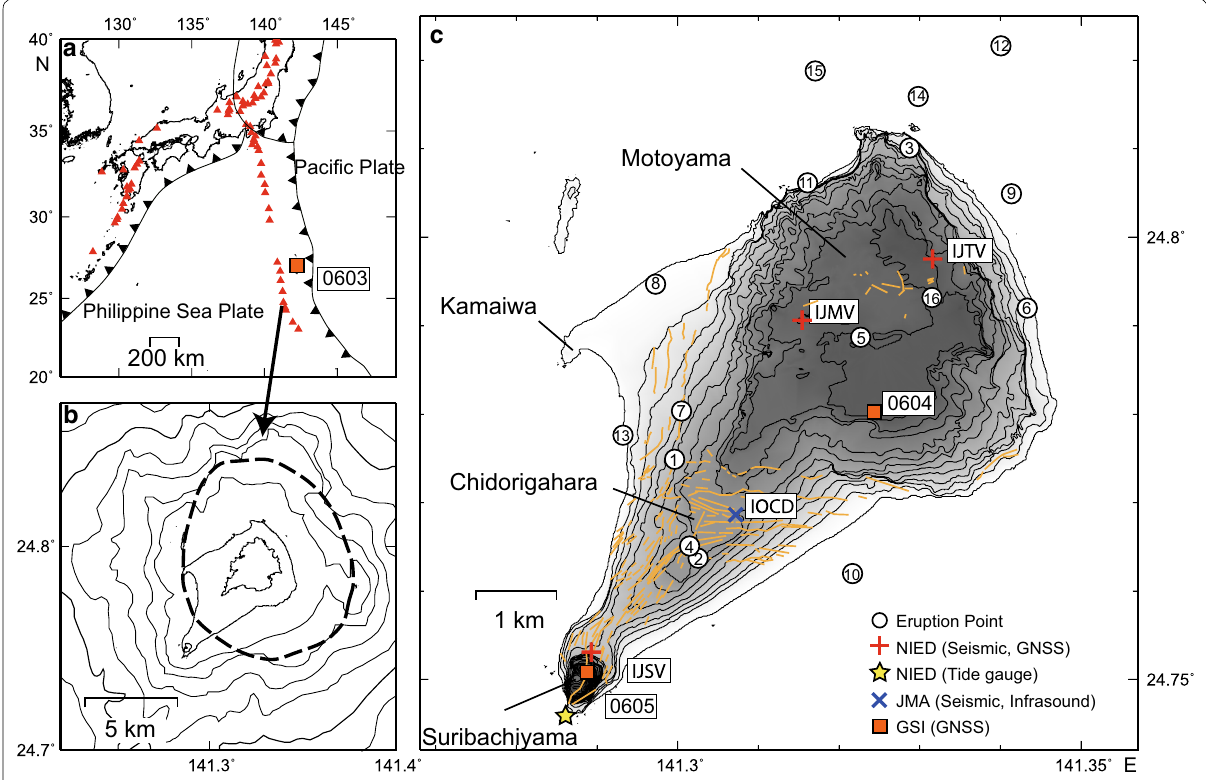
Fig. 1 Location map. a Tectonic environment around Ioto Island. Lines show plate boundaries. Red triangles are active volcanoes in Japan. Ioto Island is a volcanic island belonging to the Izu-Bonin-Mariana volcanic arc. Square shows location of a reference GNSS station of GSI on Hahajima Island. b Map of Ioto Island. The broken circle is the estimated caldera rim of Ioto volcano using bathymetry. c Topography of Ioto Island and loca- tions of continuous observation stations and eruption points. Motoyama is a resurgent dome formed in the central part of the caldera (Newhall and Dzurisin 1988). Suribachiyama is a monticule in the southwest of Ioto. Circles with numbers are eruption points after 1922. The numbers correspond to the numbers in Table 1. Crosses and squares are observation stations. Orange lines are active faults (Kaizuka et al. 1983, 1985). Contour intervals of topography are 10